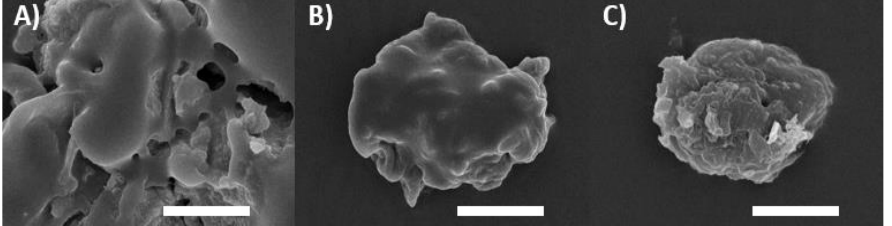
Figure 1. SEM images: ( A – C ) Characterizing NAC polymer ionic complexes with PEI, Eudragit E 100, and Eudragit RS 100, respectively.